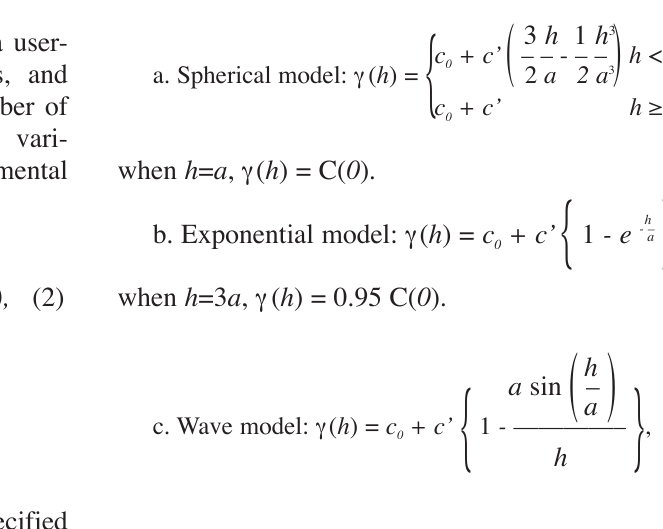
reaches the sill periodically, for h= π a and